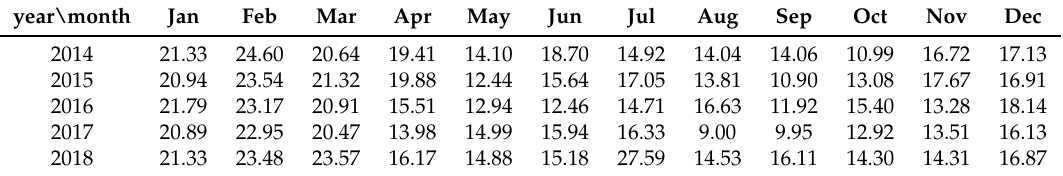
Table A14. Monthly maximums for currents for the years 2014–2018.